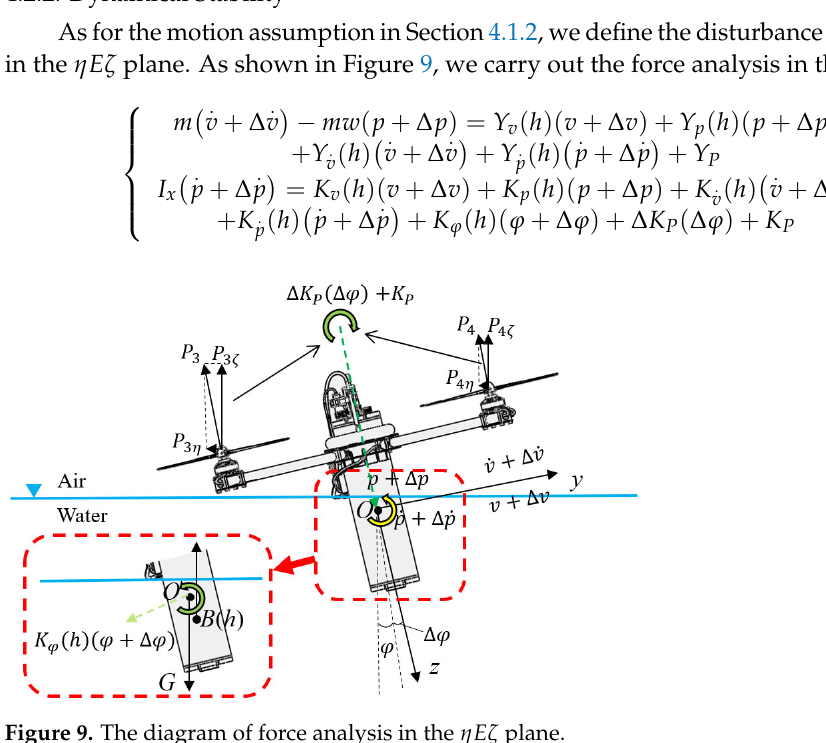
Figure 8. Static force analysis in the (cid:2015)(cid:1831)(cid:2014) plane.